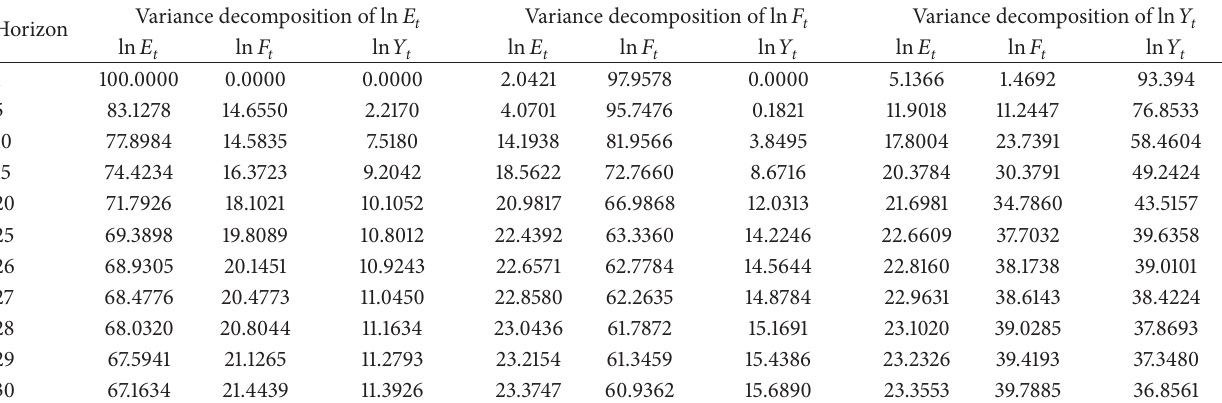
Table 9: Variance decomposition method